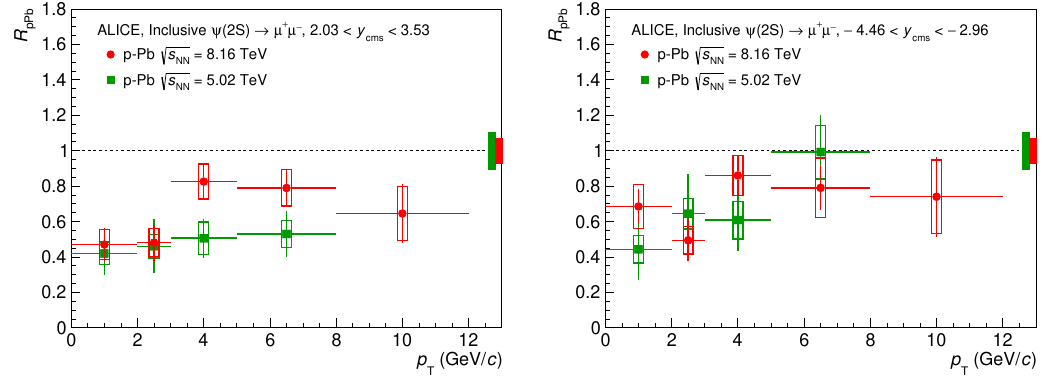
Figure 9 . Comparison of the transverse-momentum dependence of R pPb for (2S) in p-Pb collisions p at s NN = 8 : 16 and 5.02 TeV [31]. The error bars represent the statistical uncertainties, while the boxes correspond to uncorrelated systematic uncertainties and the boxes at R pPb = 1 to correlated systematic uncertainties, separately shown for the two energies.